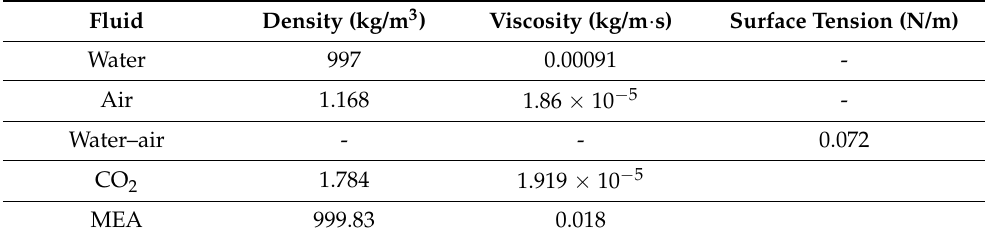
Table 3. Fluid properties of the designed 3D liquid–gas ejector.